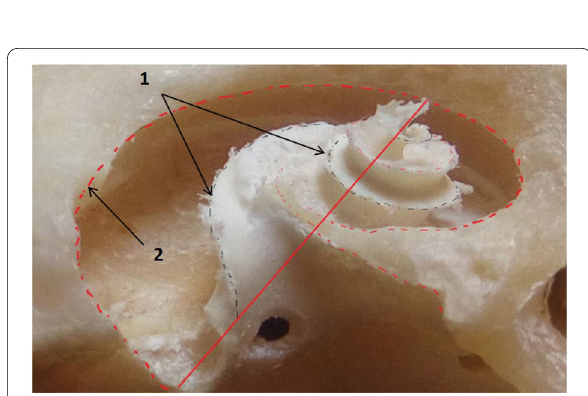
Fig. 7 Gross morphological image of the camel cochlea. 1.